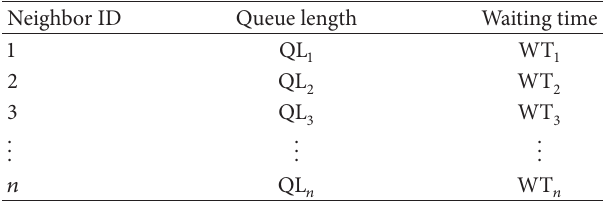
Table 1: Neighbor